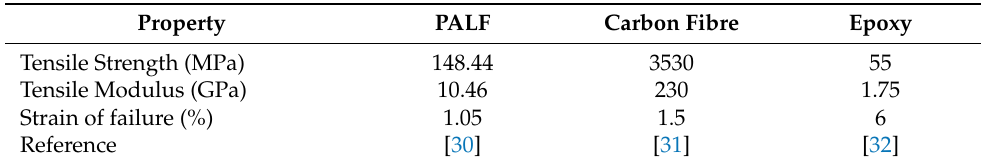
Table 1. Material properties fibres and matrix polymers.